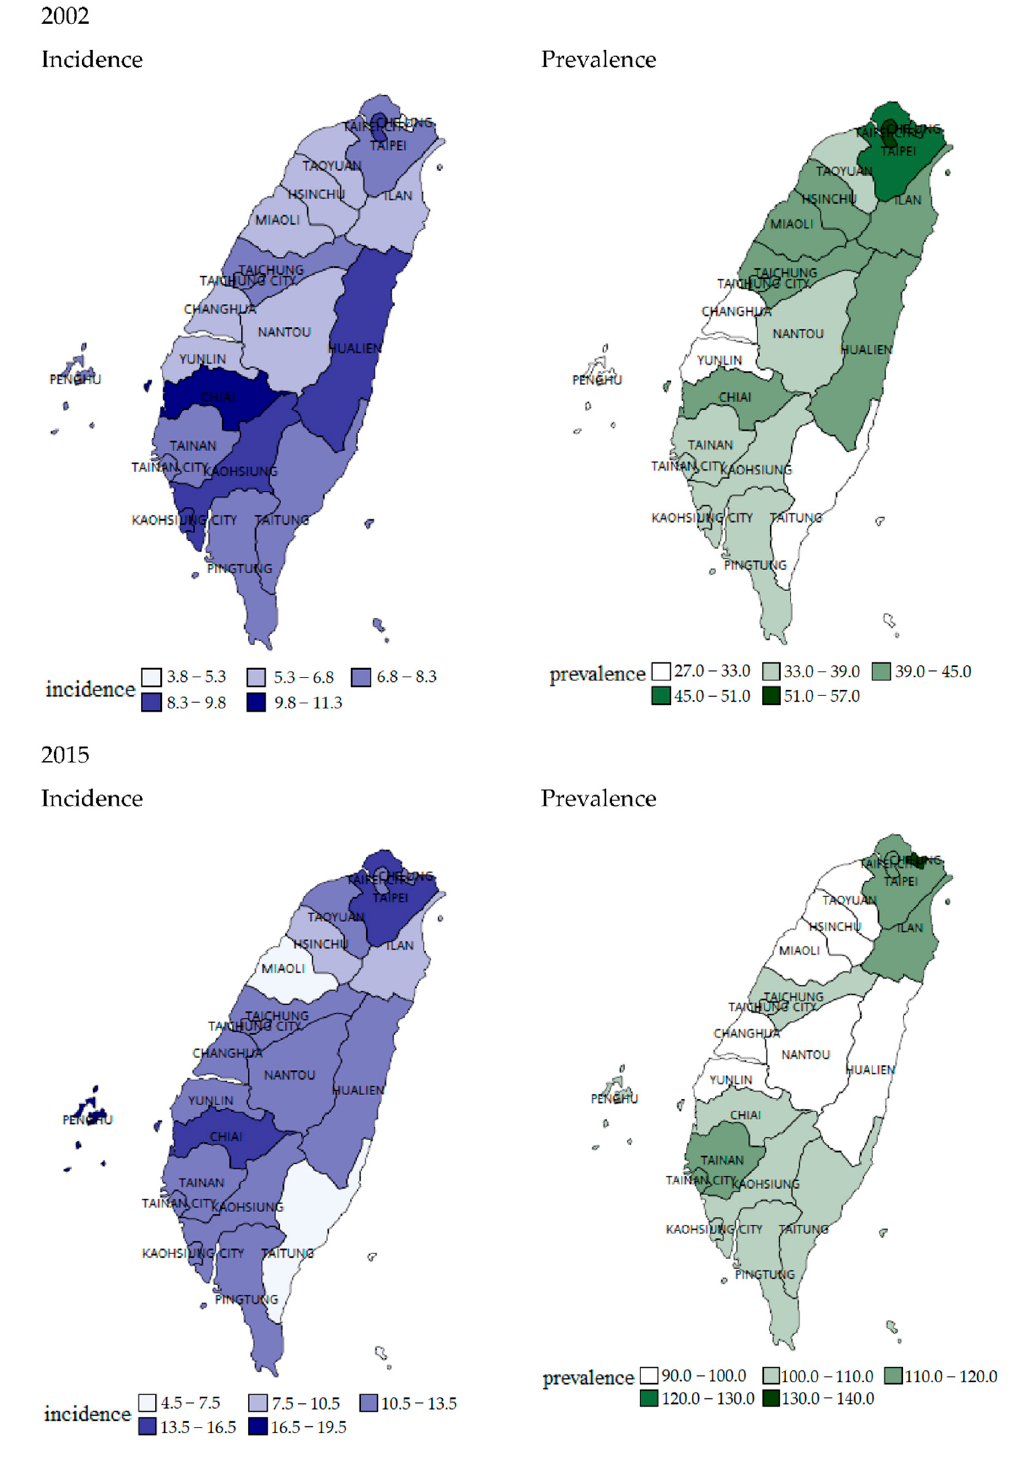
Figure 2. Geographic variation in the prevalence and incidence of ovarian cancer in Taiwan (2002/2015).